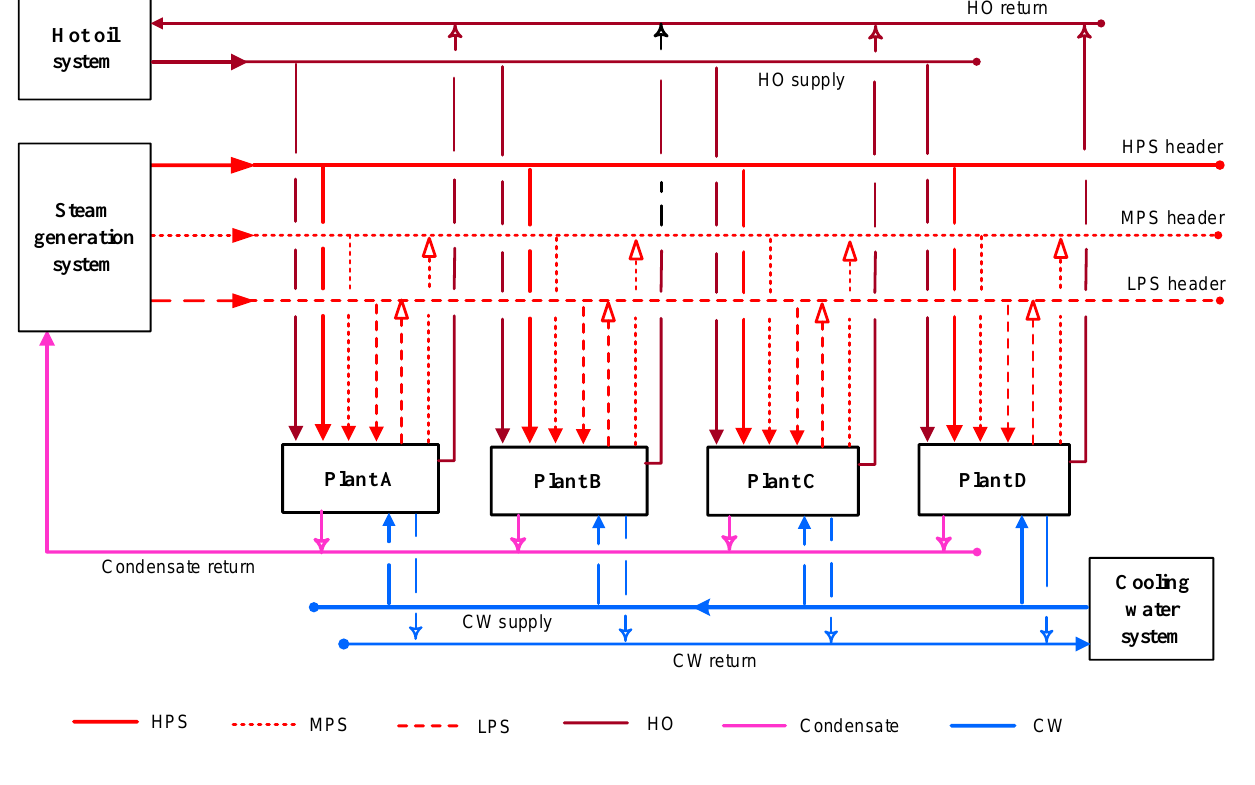
Figure 2. Schematic of a typical utilities distribution system at a TS with HO, HPS/MPS/LPS and cooling